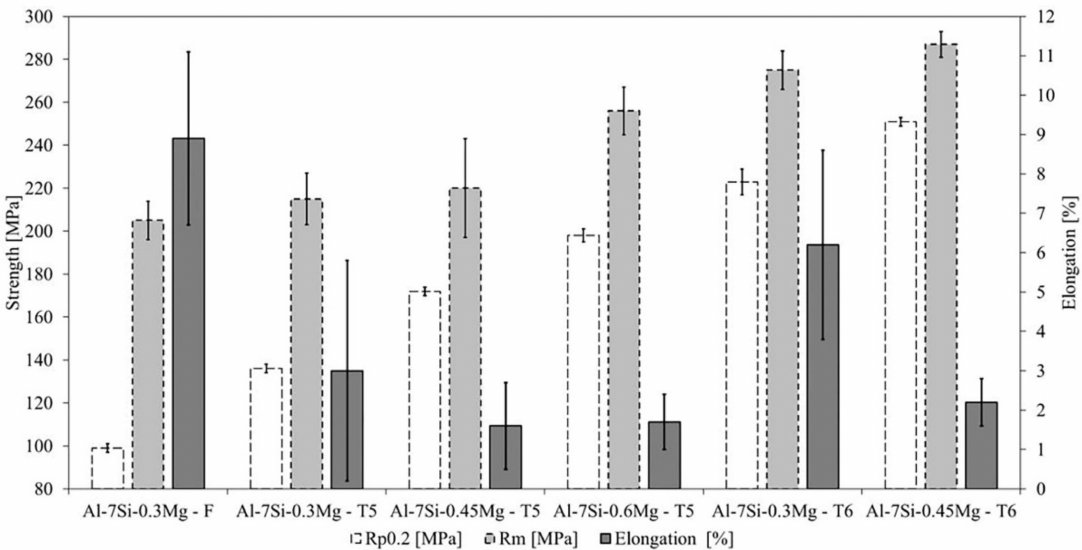
Figure 11. Tensile strength, 0.2% o ff set yield strength and % elongation of SSM castings in the di ff erent conditions. Error bars show the standard deviation of the